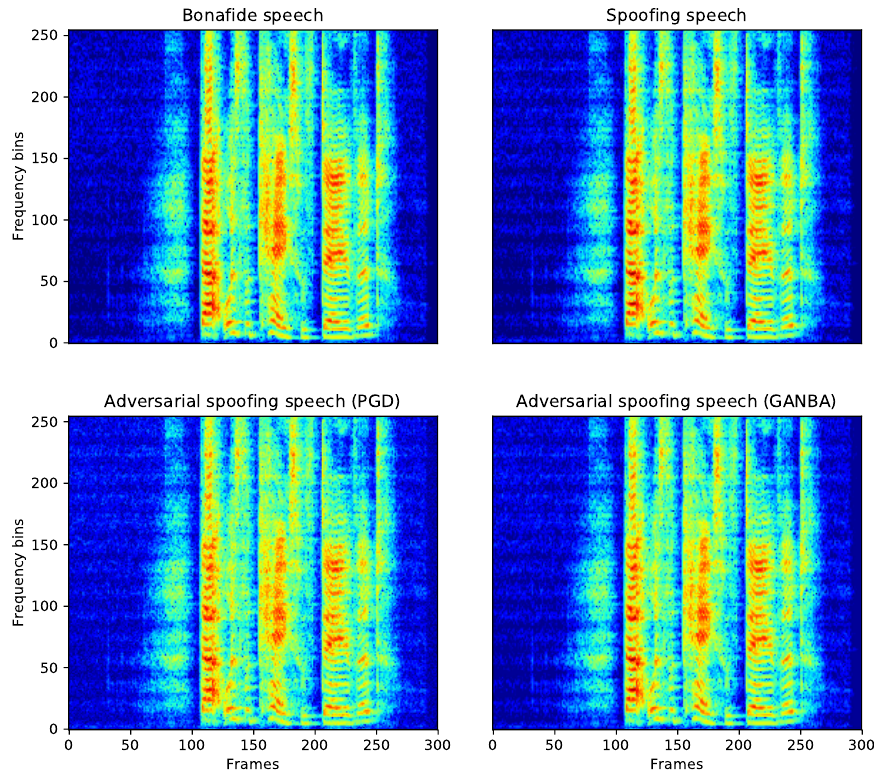
Figure 7. Spectrograms of the same utterance corresponding to: ( left upper ) bonafide speech, ( right upper ) spoofing speech generated with a replay attack, ( left bottom ) adversarial spoofing speech generated with the black-box PGD ( (cid:101) = 1.0 ) method, ( right bottom ) adversarial spoofing speech generated with the proposed black-box GANBA